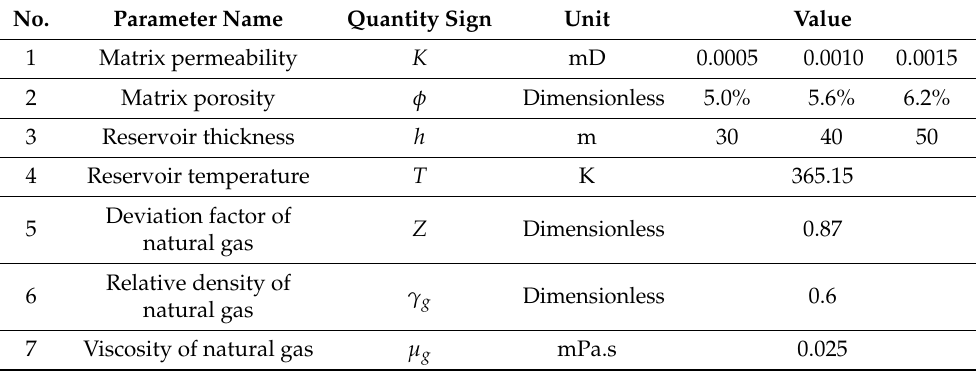
Table 2. Reservoir geological parameters of the shale gas horizontal well.